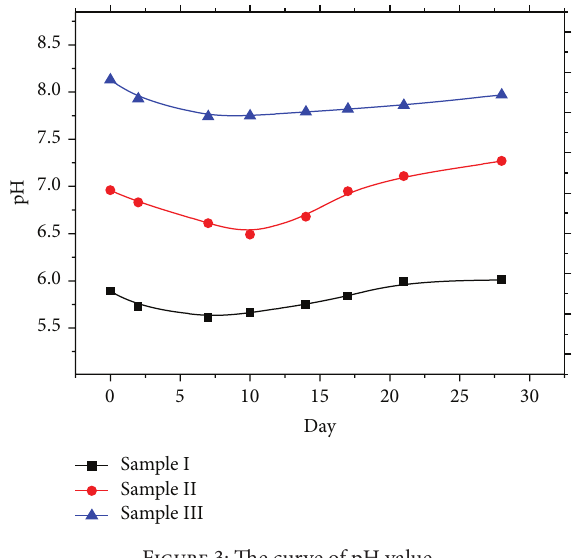
Figure 3: The curve of pH value.